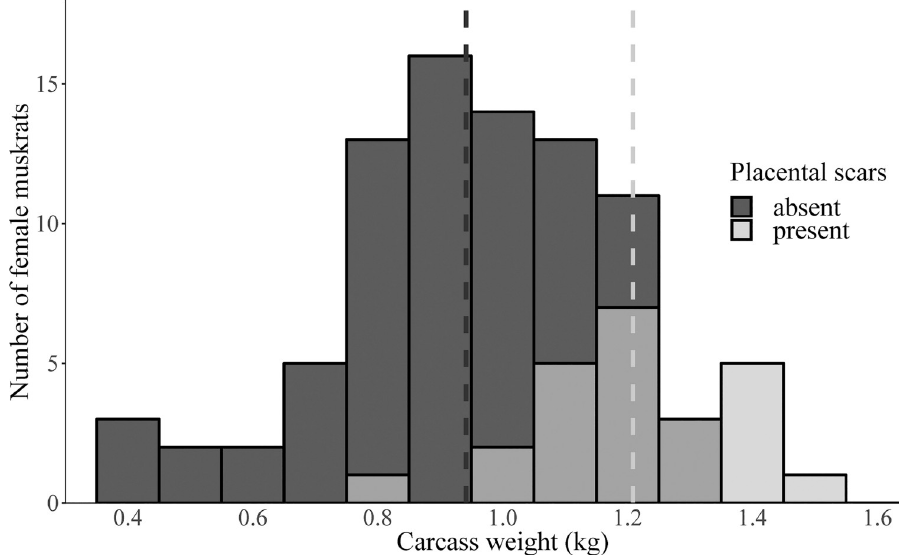
Fig 4. Distribution of female muskrat ( Ondatra zibethicus ) carcass weight (kg) with respect to the presence or absence of placental scars in Pennsylvania, USA, 2018–2019. Mean weight for each group is indicated by dashed